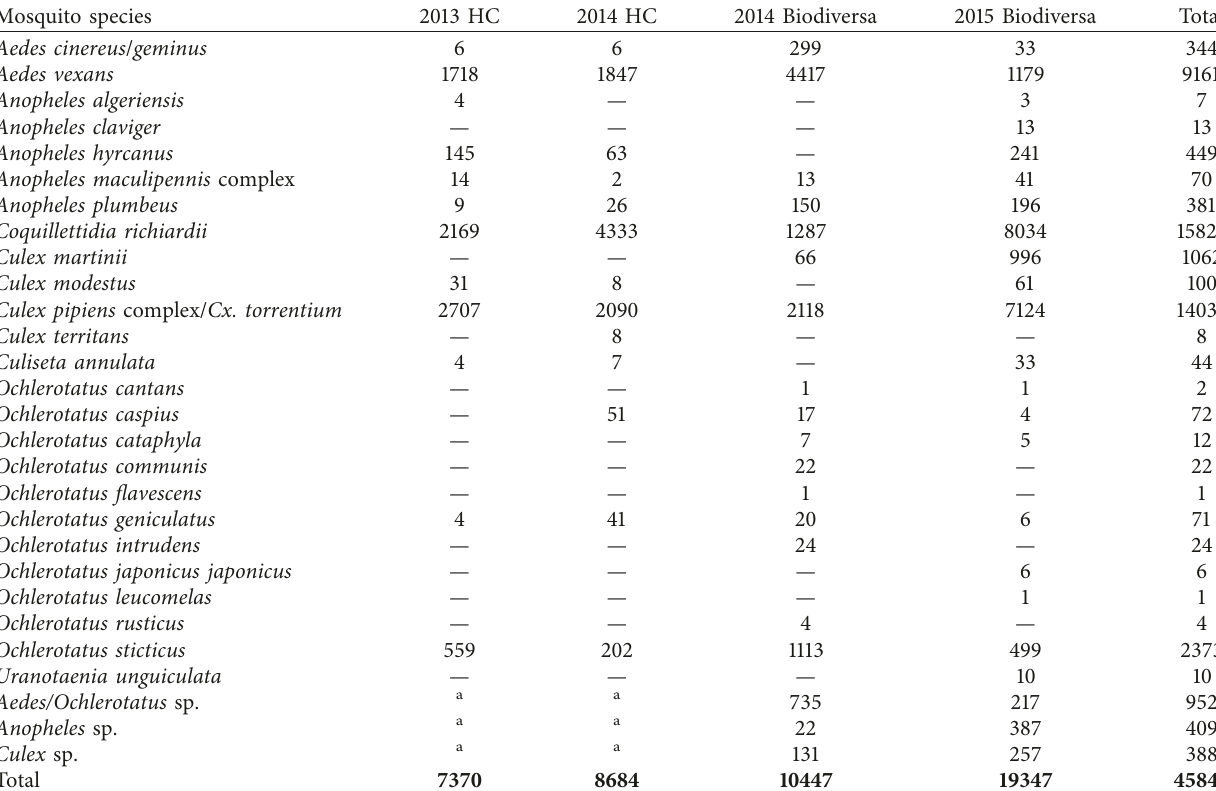
Table 1: Number of mosquitoes and species collected in Eastern Austria included within this